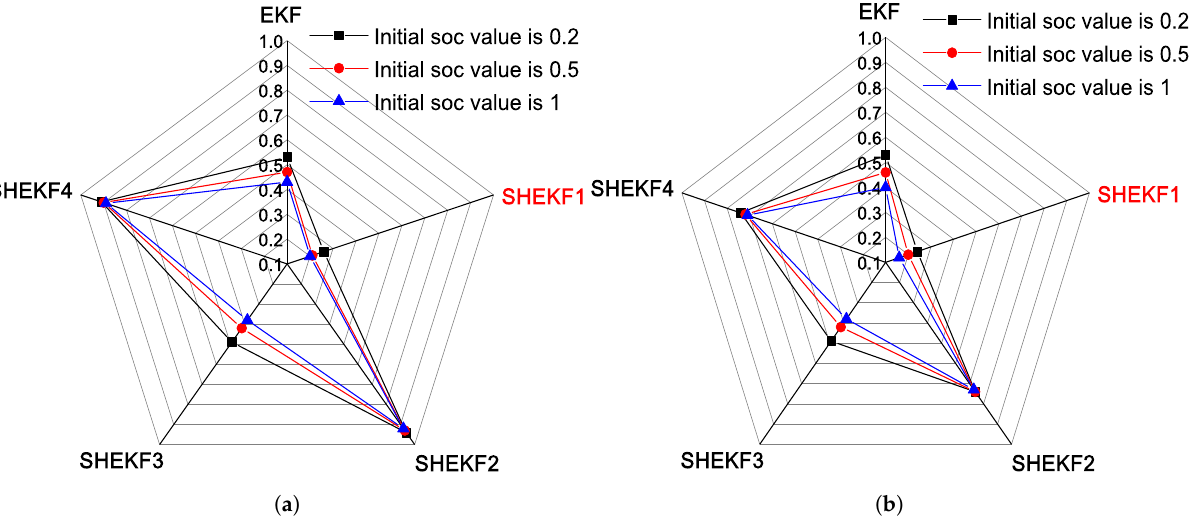
Figure 11. MAE and RMSE of different algorithms with different SOC initial value: ( a ) MAE, ( b )